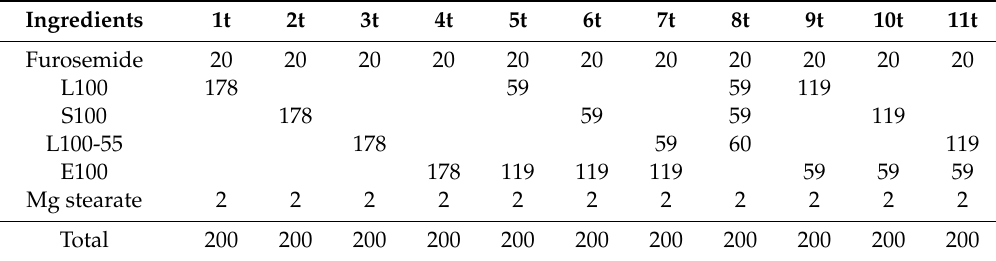
Table 2. Composition (in mg) of matrix tablets of formulations